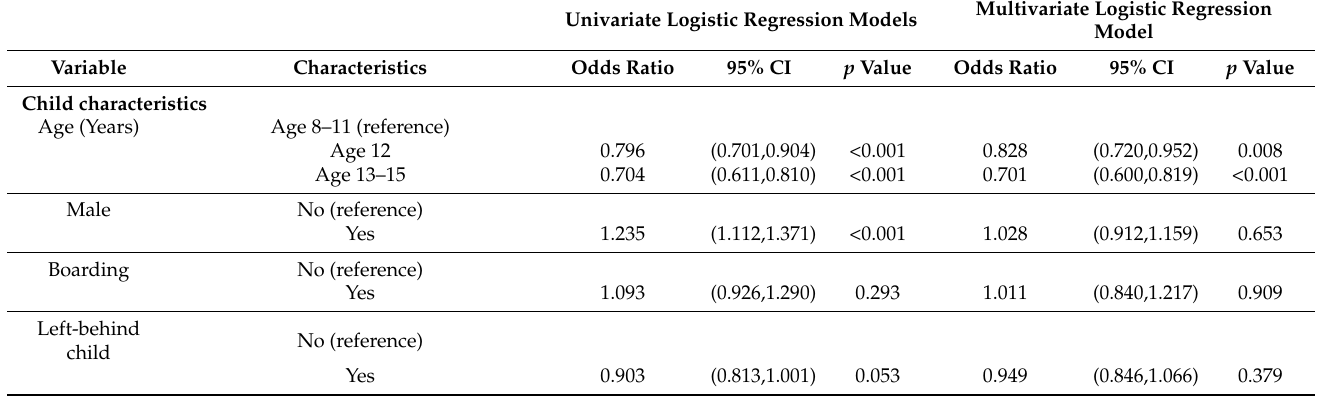
Table 3. Logistic regression of factors associated with total difficulties scores in the abnormal score of the Strengths and Difficulties